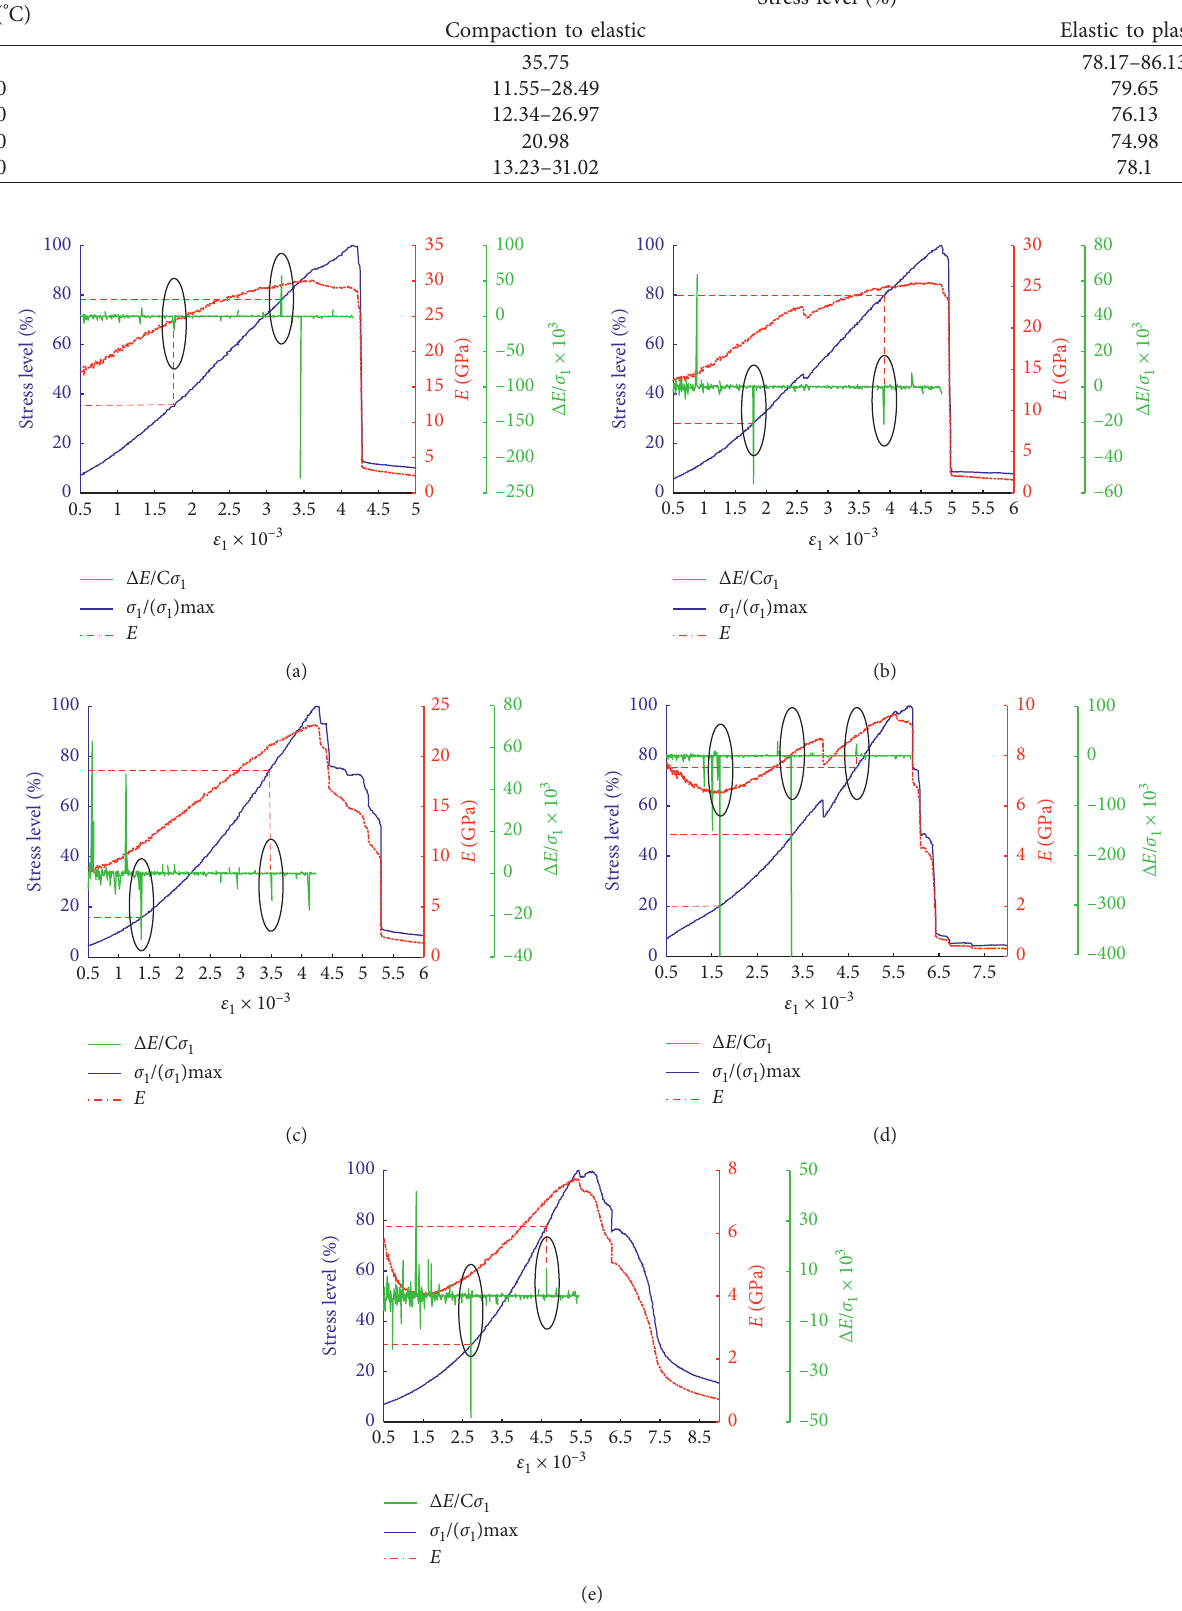
Figure 6: Evolution curve of the increment ratio of elastic modulus to axial pressure. (a) 25 ° C, (b) 200 ° C, (c) 400 ° C, (d) 600 ° C, and (e) 800 °